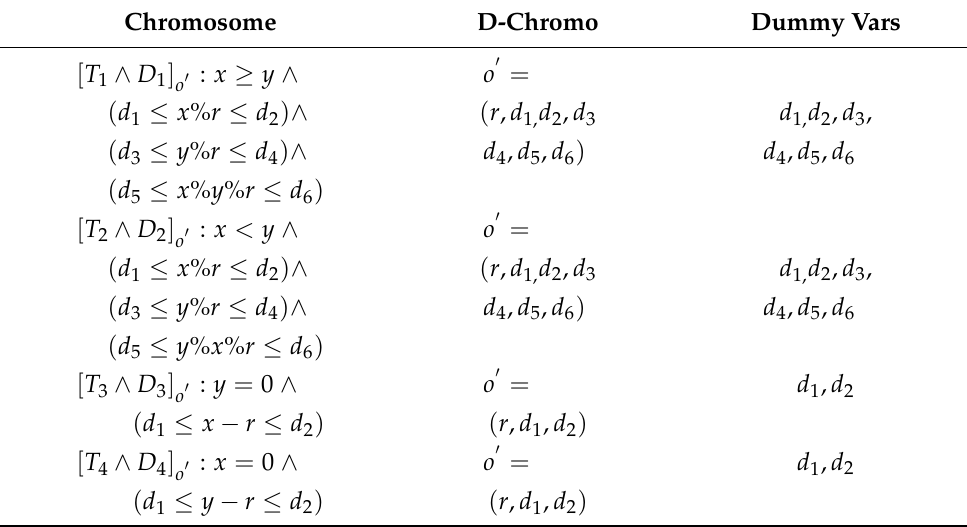
Table 4. Chromosome forms for functional scenarios of process gcd.